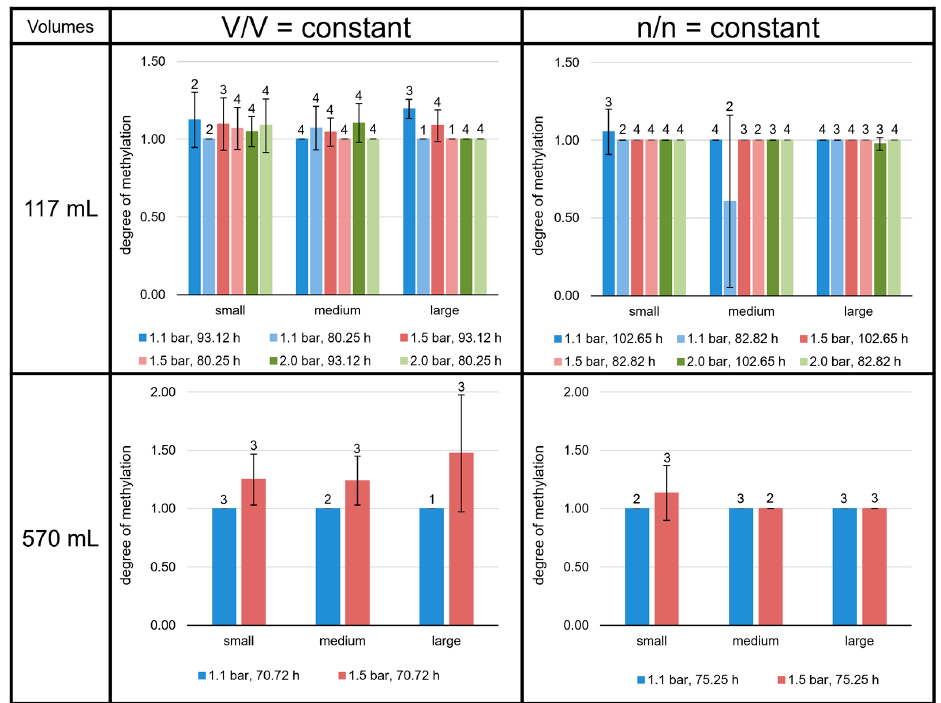
Figure 9. Degree of methylation of the M. marburgensis cultures. Pressure is given in bar relative to atmospheric pressure. Errors are standard deviations. Numbers above bars indicate number of samples.